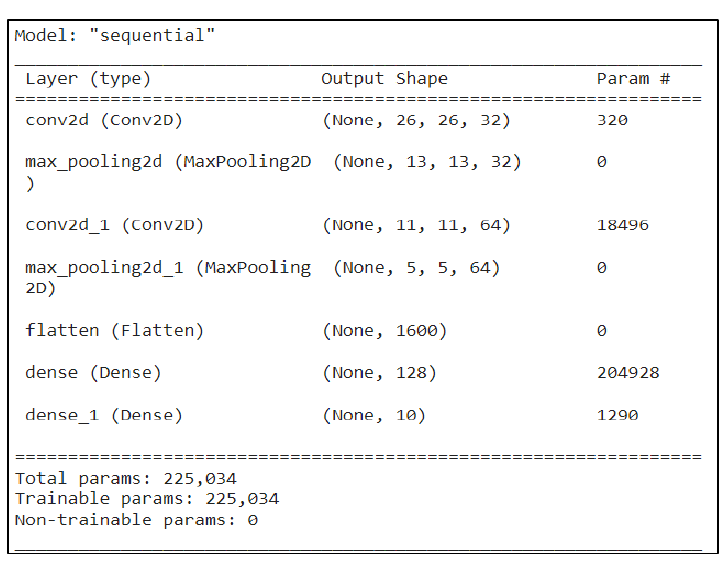
Figure 4. Effective CNN model